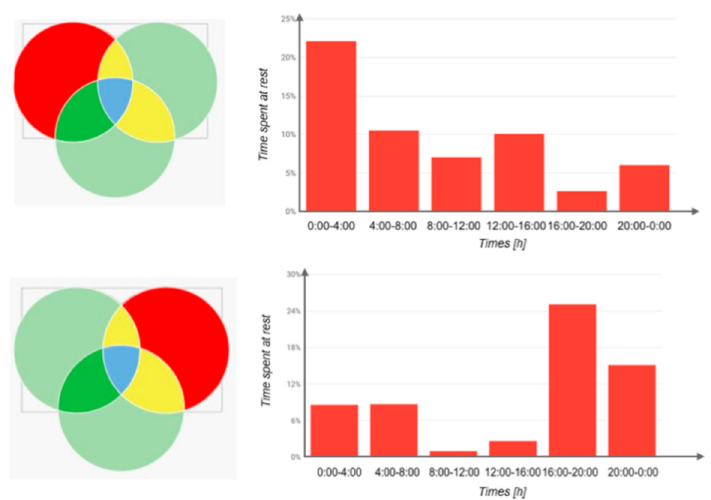
Figure 8. The time spent by the selected animal at the red